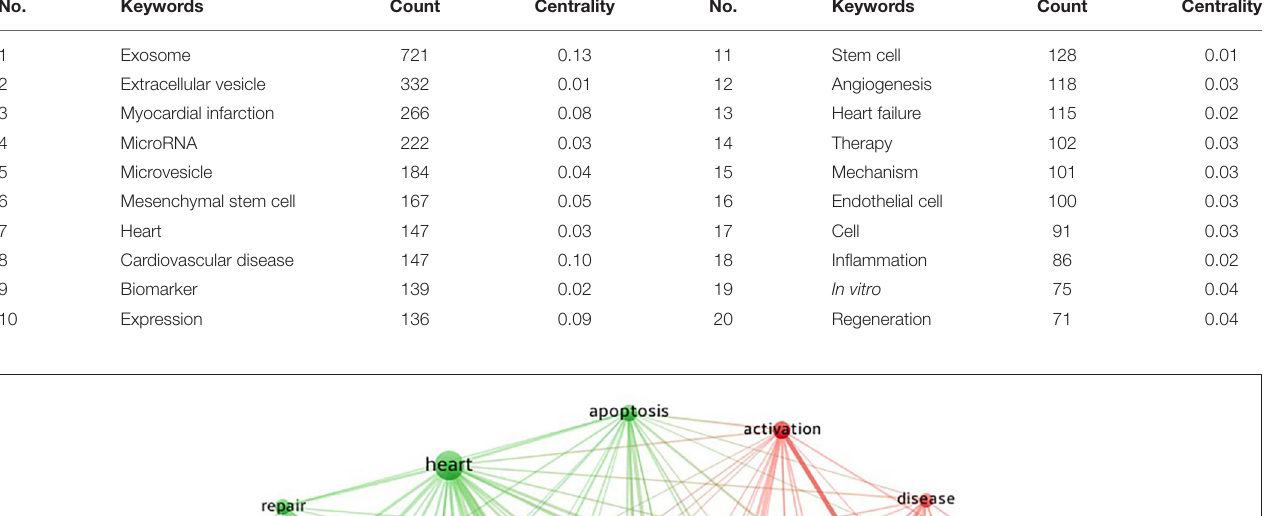
TABLE 5 | Top 20 keywords related to exosomes in CVDs. No.